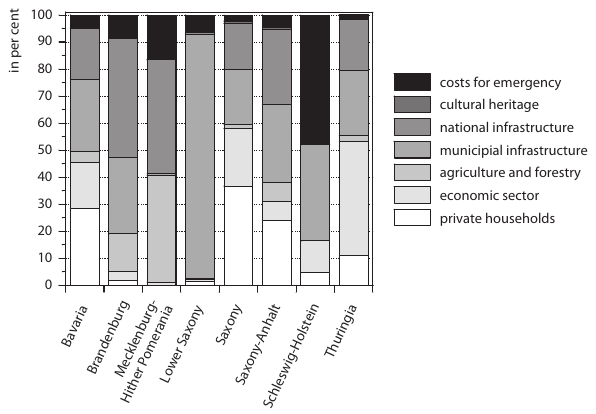
Fig. 5. Share of different damage categories of the 2002 floods in the federal states of Germany; source: estimates as at 2003 were reported to EU solidarity